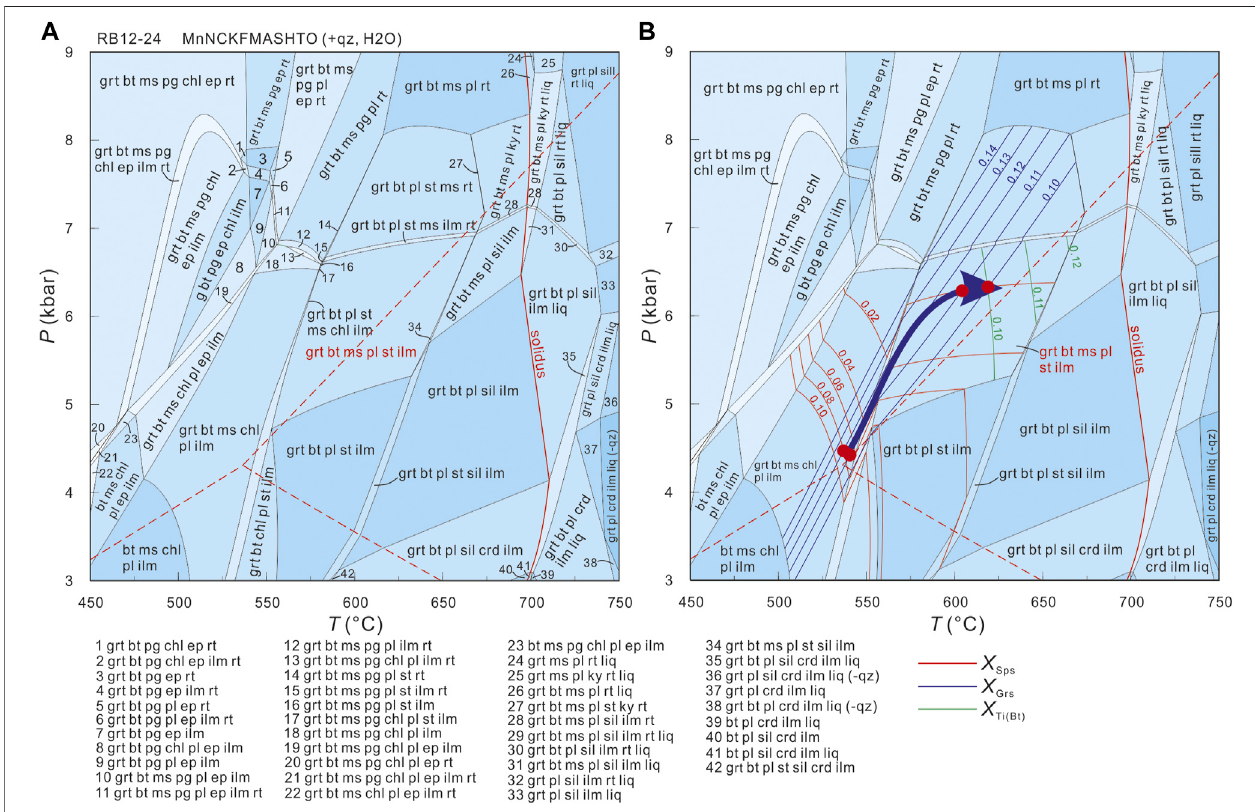
FIGURE 8 | P – T pseudosections for the garnet – staurolite – two-mica schist sample RB12-24. (A) P – T pseudosection that shows mineral assemblages. (B) P – T pseudosection with isopleths of X Sps and X Grs in garnet and X Ti in biotite. The fi eld of peak mineral assemblage is marked by grt – bt – ms – pl – st – ilm – qz – H 2 O in red type.